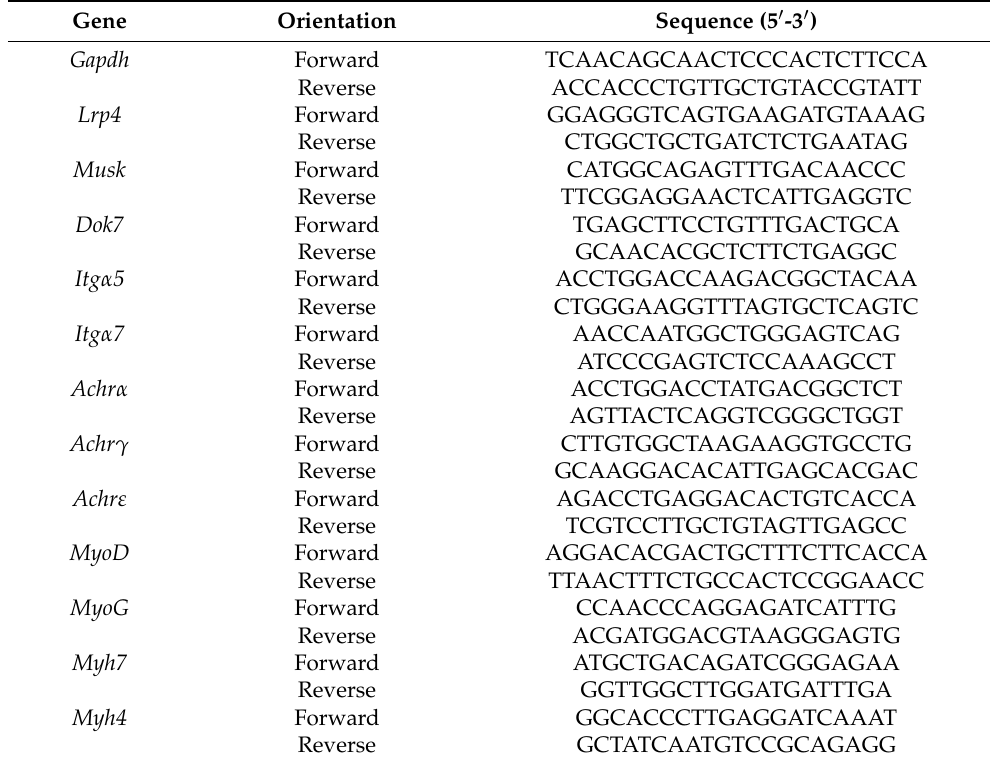
Table 1. Primers used in this study.